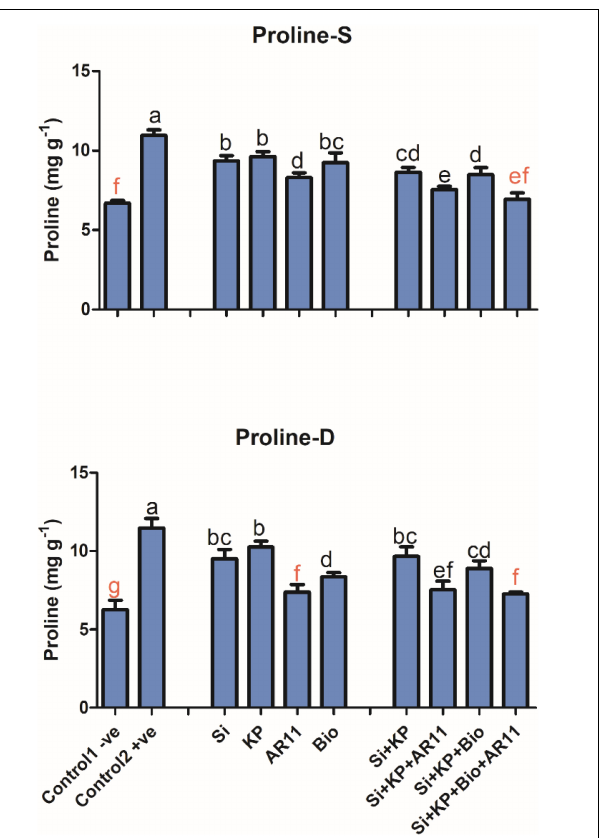
FIGURE 8 | Analysis of proline content in plant shoots subjected to salt and drought stresses. (-S), salt; (-D), drought. Error bars represent standard deviations. Each data point represents the mean of at least three replications. Bars with different letters are significantly different from each other at P ≤